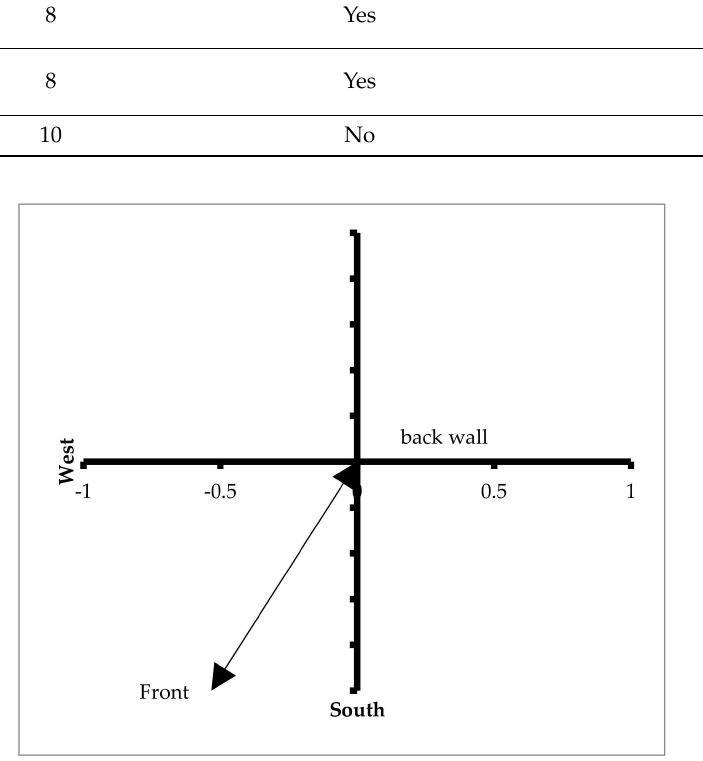
Figure 6. Location of the front wall of the planned single-family house and its inflection from the southern